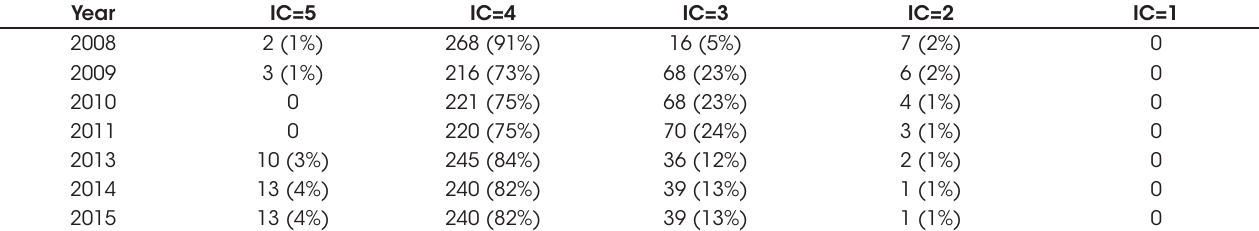
IC bridges distribution of Fernão Dias road dataset